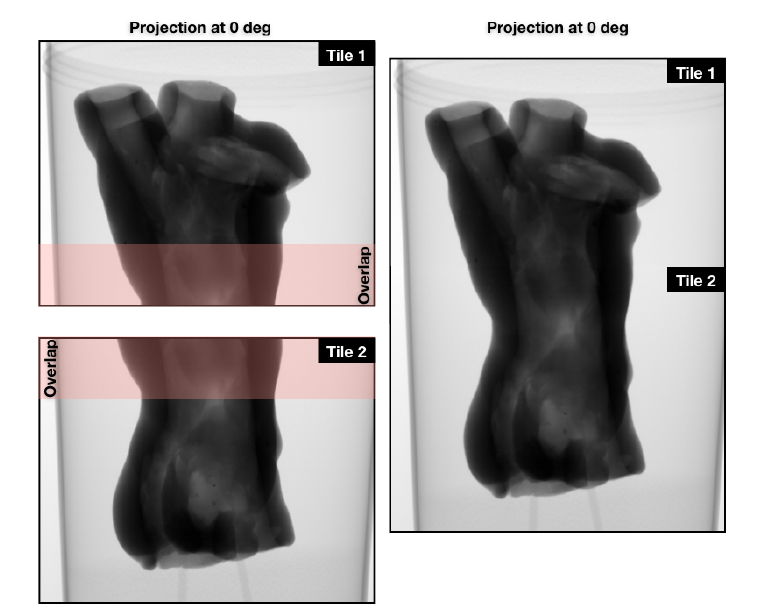
Figure 7. The tile radiographs on the left with the overlapping zone highlighted, and the stitched radiograph on the right.